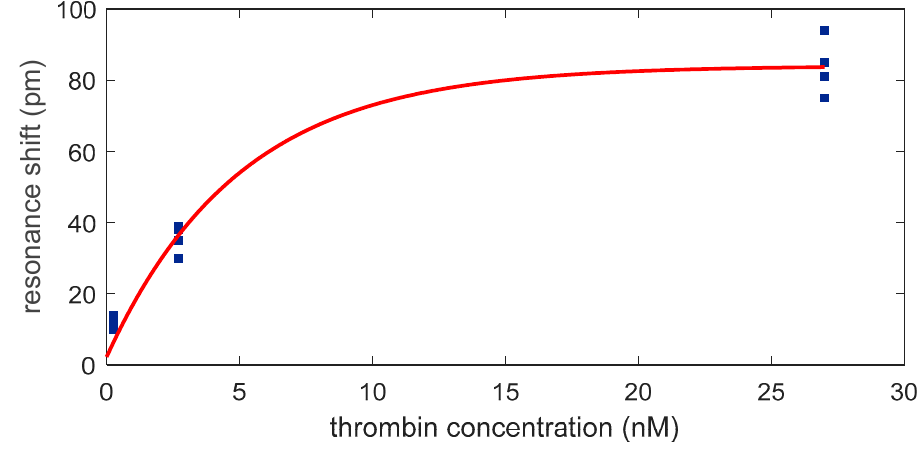
Figure 8. Dependence of the optical aptasensor response with the thrombin concentration.